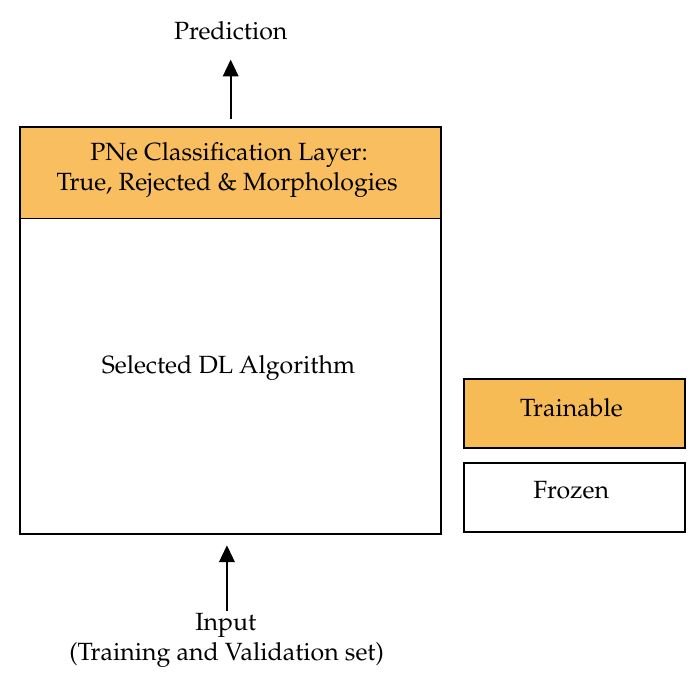
Figure 5. Conceptual view of the Deep Transfer Learning (DTL) Architecture used in this